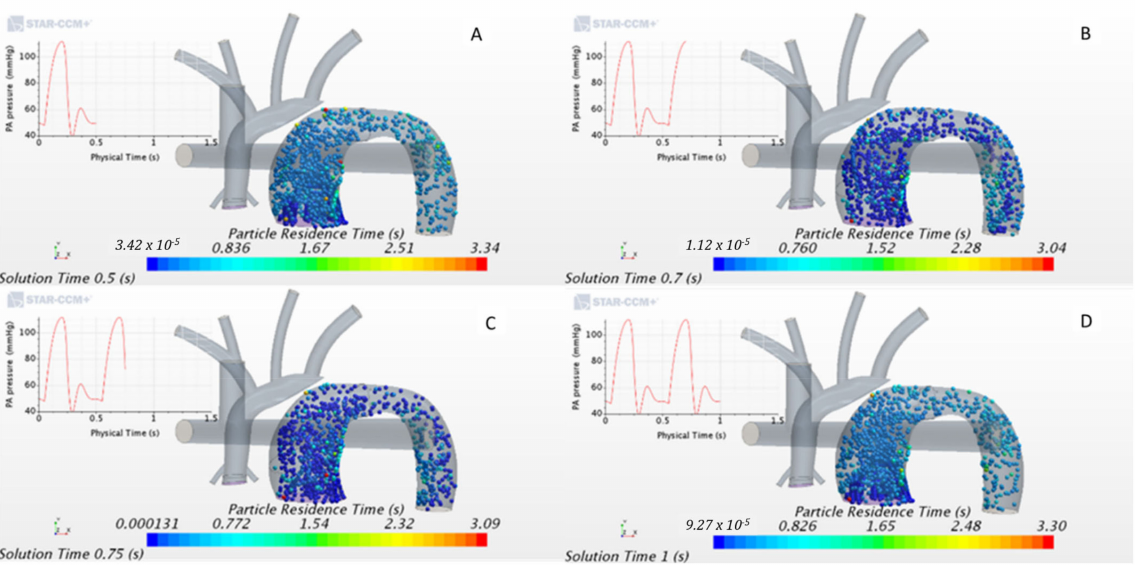
Figure 22. Particle residence time at different points of the cardiac cycle ( A ) = early systole, ( B ) = peak systole, ( C ) = early diastole, and ( D ) = late diastole). The results show that particles take less than ~0.5 s to exit the fluid domain (0.5 s being a single heart cycle). However, it must be noted that some particles took longer to flow downstream ( ≥ 3 s), as shown in Figure